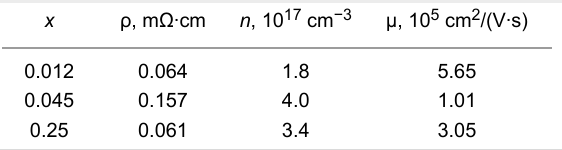
Table 1: The values of resistivity, ρ , free electron concentration, n , and mobility, μ , for (Cd 1 − x Zn x ) 3 As 2 samples at T = 4.2